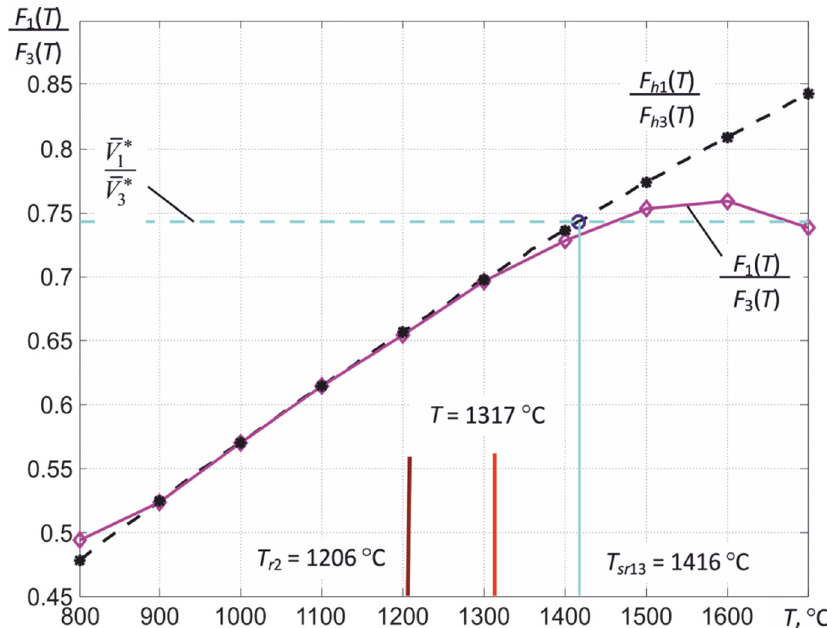
Figure 19. The temperature dependence of the F 1 ( T )/ F 3 ( T ) ratio obtained by calibrating the available thermograph sample (solid line) and the calculated F h 1 ( T )/ F h 3 ( T ) (dashed line), as well as an illustration of the process of their use in determining the temperature of the spectral ratio T sr 13 of a tungsten tape of a standard incandescent lamp SI10–300 at a temperature of partial radiation of its most heated section T r 2 = 1206 °C.